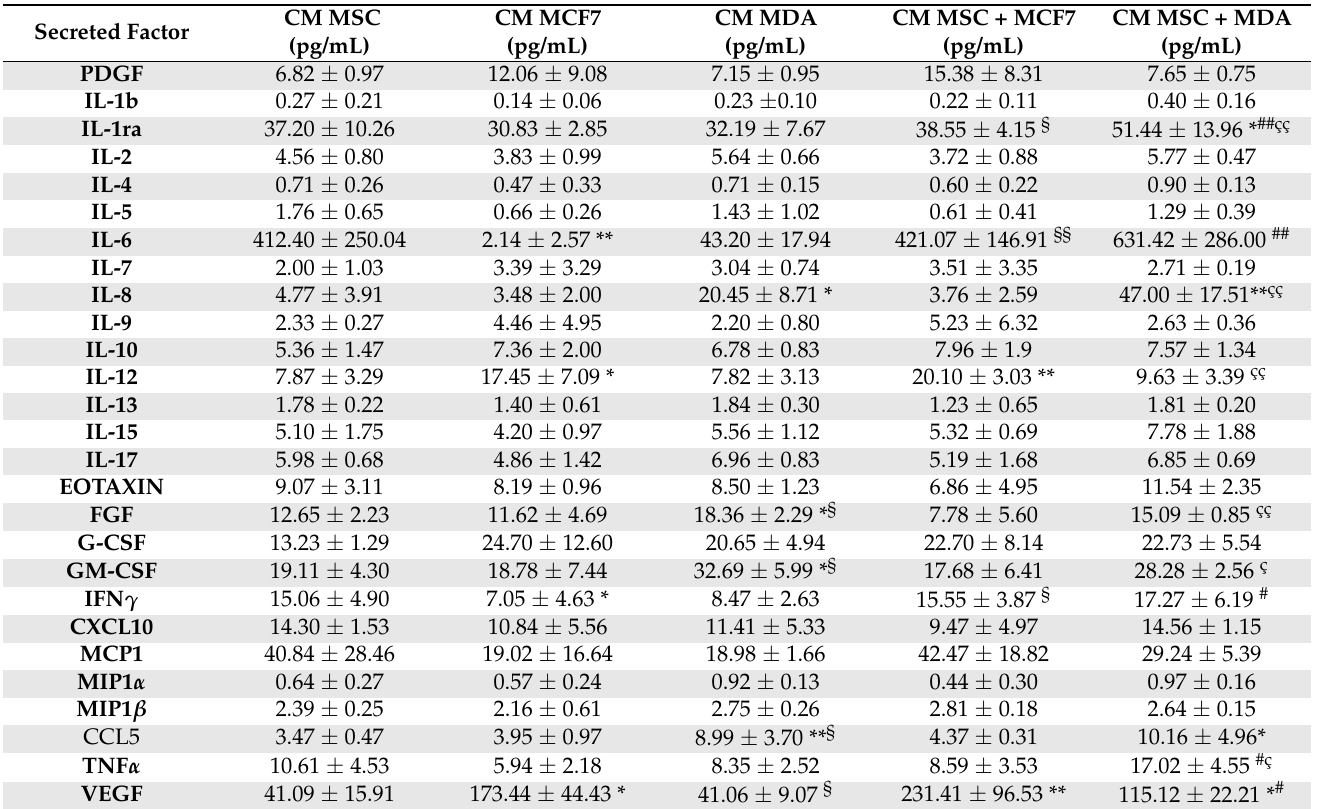
Table 1. Cytokine, chemokine and growth factor concentration (pg/mL) in conditioned media (CM) from mono-cultured and co-cultured cells. MCF7 or MDA-MB231 were co-cultured—and not—with MAT-MSCs in standard/high glucose (25 mM glucose; MSC). After 72 h, CM from mono- cultured and co-cultured MAT-MSCs, MCF7 and MDA-MB231 were collected and analyzed by using the bio-plex multiplex human cytokine and growth factor kits (see Methods). Data were reported as mean ± SD of 5 independent experiments. For multiple comparisons, Kruskall–Wallis test followed by Dunn’s correction was applied. For pairwise comparisons (CM MAT-MSCs + MCF7 vs. CM MAT-MSCs + MDA-MB231) Mann–Whitney test was assessed. * denotes statistically signif- icant values vs. MAT-MSCs (* adjp < 0.05; ** adjp < 0.01); § denotes statistically significant values compared with MCF7 ( § adjp < 0.05; §§ adjp < 0.01); # denotes statistically significant values